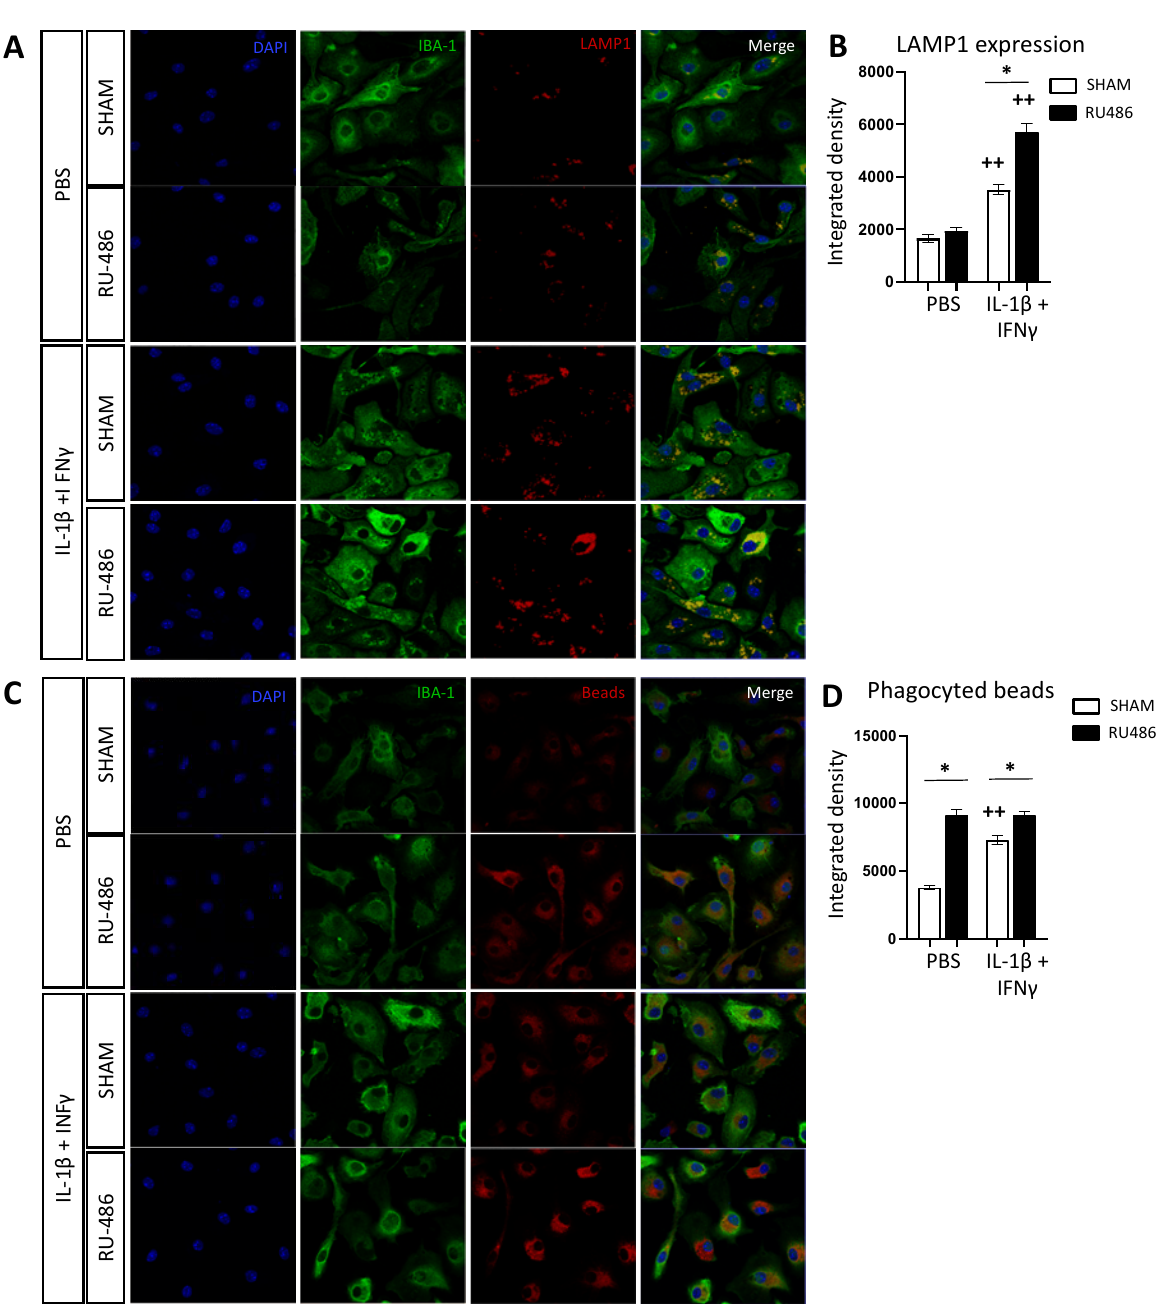
Figure 5. RU-486 increases microglial lysosome LAMP-1 expression and phagocytosis in vitro. CD11B+-cell-sorted microglia were treated with RU-486 at 10 −3 M diluted in absolute ethanol (or with absolute ethanol only for SHAM group) for 1 h prior to stimulation with IL-1β + IFN-γ or with PBS as the control for 3 h. Immunofluorescence stainings were performed on IBIDI chambers. ( A ) Confocal images of LAMP1 immunofluorescence of in vitro microglial cells (stained with IBA1 antibody) after RU-486 and IL-1β+ IFN-γ exposition. ( B ) Integrated density of LAMP1 immunoreactivity in IBA1+ cells ( n = 294–582 cells/group). One-way analysis of variance (ANOVA) corrected by the Sidak test (* p ≤ 0.05 comparing RU-486 vs. SHAM, ++ p ≤ 0.01 comparing IL-1β+ IFN-γ vs. PBS). ( C ) Confocal images of phagocytic assay latex beads immunofluorescence of in vitro microglial cells (stained with IBA1 antibody) after RU-486 and IL-1β+ IFN-γ exposition. ( D ) Integrated density of fluorescence emitted from Cy3 beads in IBA1+ cells exposed to RU486 ± (IL-1β+ IFN-γ) ( n = 288–626 cells/group). One-way analysis of variance (ANOVA) corrected by the Sidak test (* p ≤ 0.05 comparing RU-486 vs. SHAM, ++ p ≤ 0.01 comparing IL-1β + IFN-γ vs. PBS).